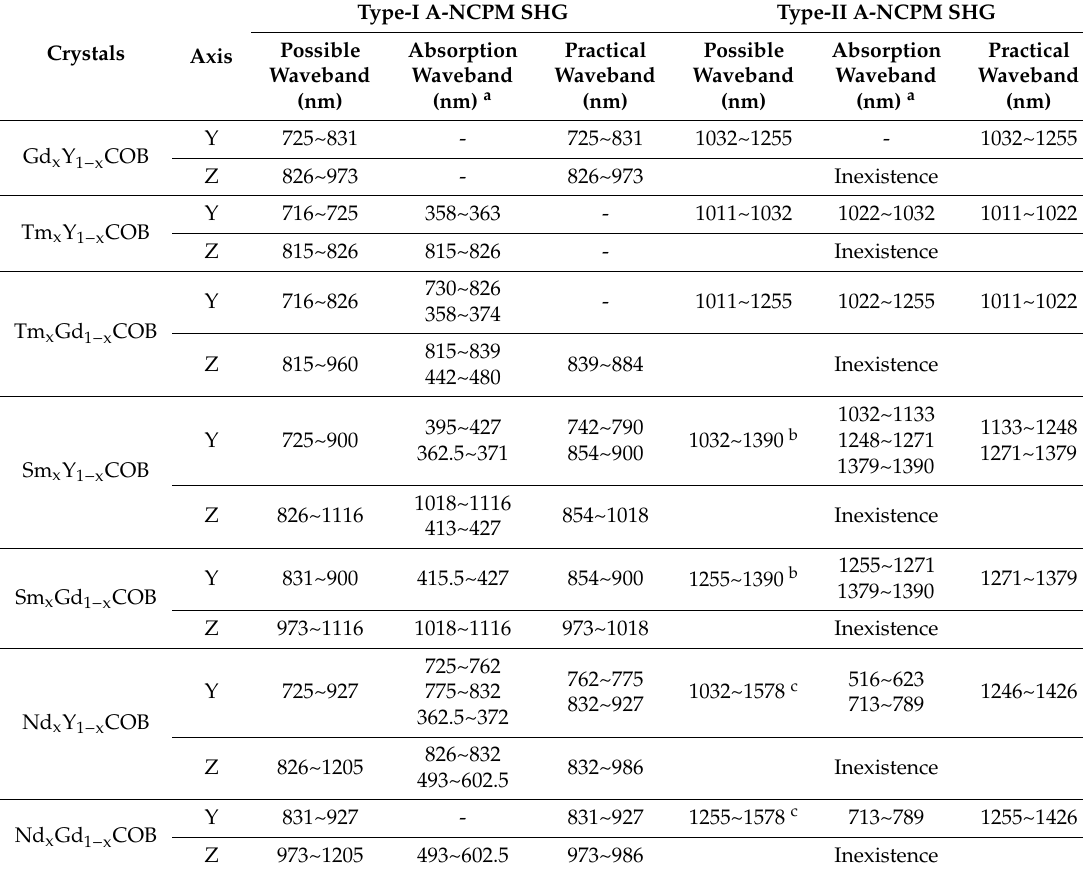
Table 4. A-NCPM SHG wavelength tuning ranges of di ff erent mixed RE1 x RE2 1 − x COB